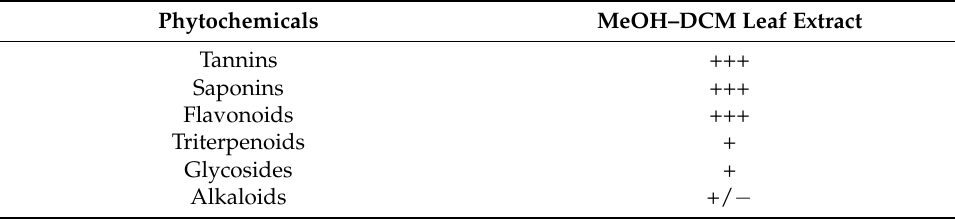
Table 1. Qualitative phytochemical screening of MeOH-DCM leaf extracts of O. strictum . Phytochemicals MeOH–DCM Leaf Extract Tannins +++ Saponins +++ Flavonoids +++ Triterpenoids + Glycosides + Alkaloids +/ − +++: strong presence; +: presence; +/ − : in very small